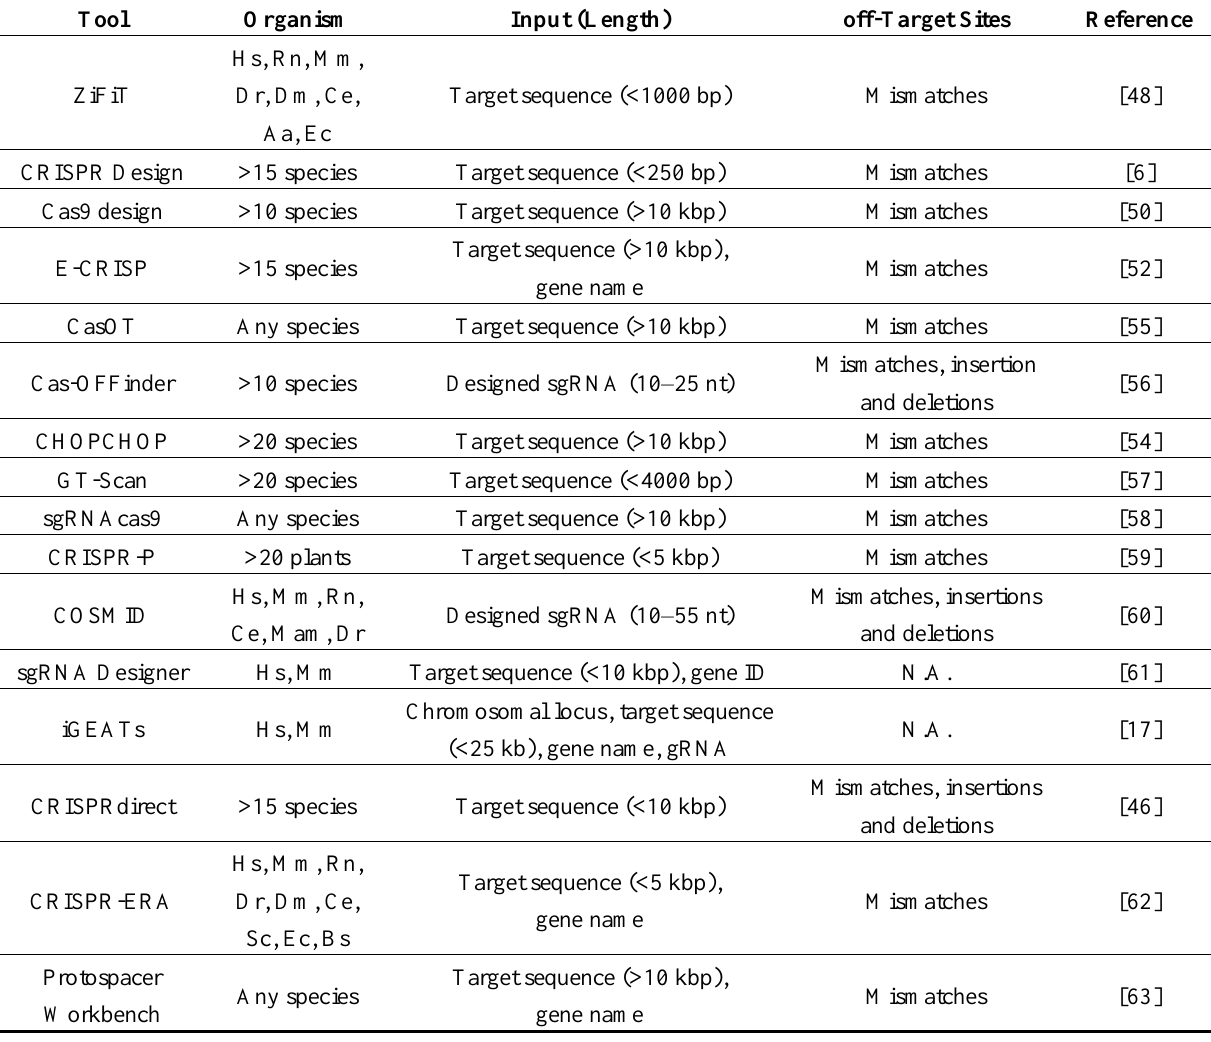
Table 1. Software to design CRISPR (clustered regularly interspersed short palindromic regions) sgRNA (single guide